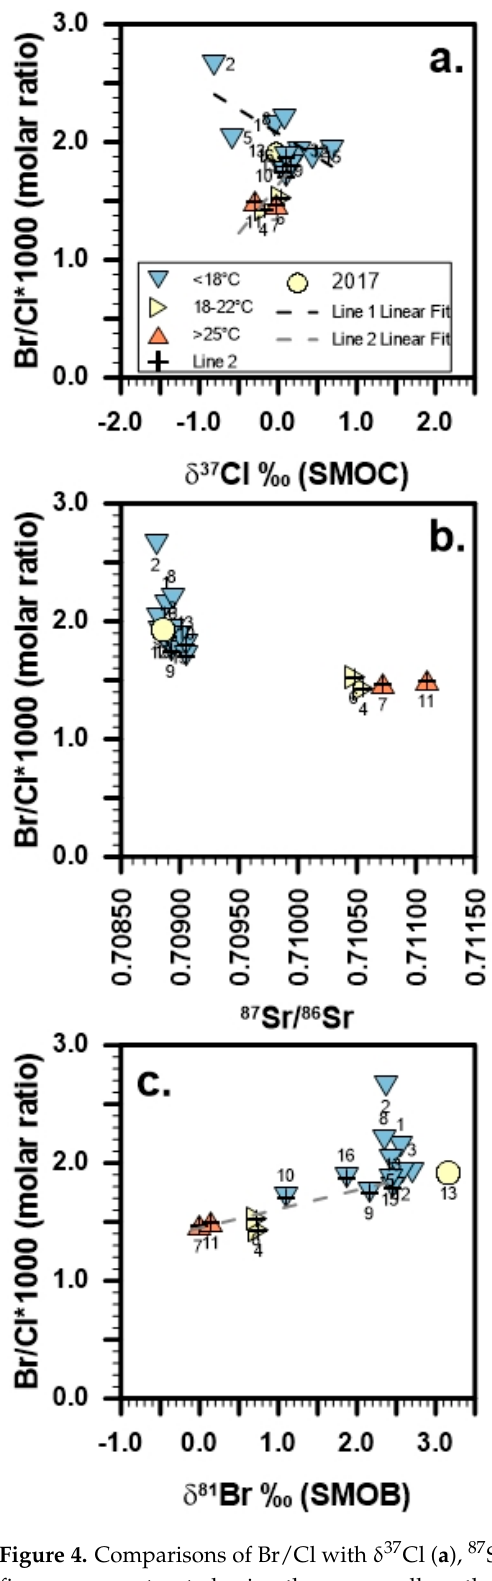
Figure 4. Comparisons of Br/Cl with δ 37 Cl ( a ), 87 Sr/ 86 Sr ( b ), and δ 81 Br ( c ). Linear fit 1 and 2 in this figure are constructed using the same wells as those along Lines 1 and 2 in Figure 3e. The samples with a ‘+’ symbol denote those that fall along line 2 in Figure 3e.